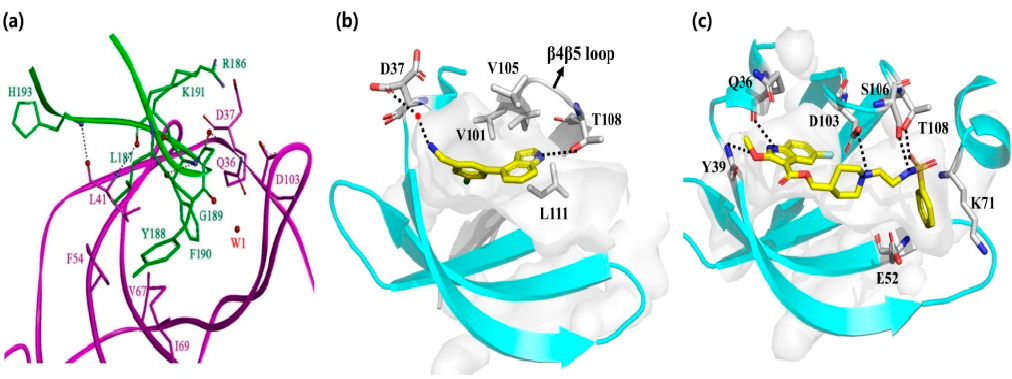
Figure 3. Interaction between ( a ) Pc, ( b ) compound 3 and ( c ) 4 with α / β